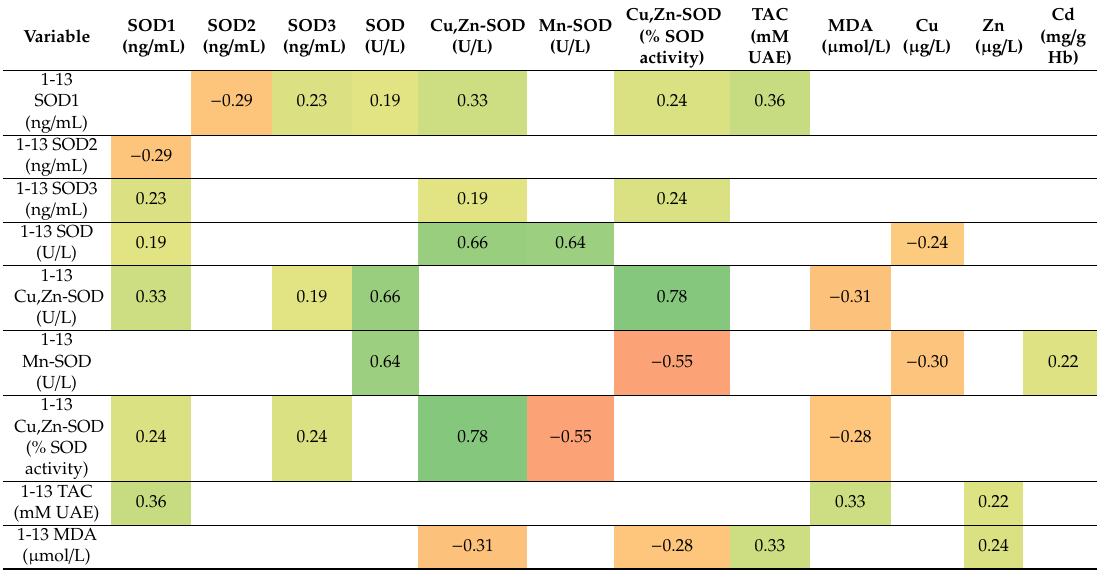
Table 7. Spearman correlation matrix between selected variables, in the entire population sample ( n = 94).